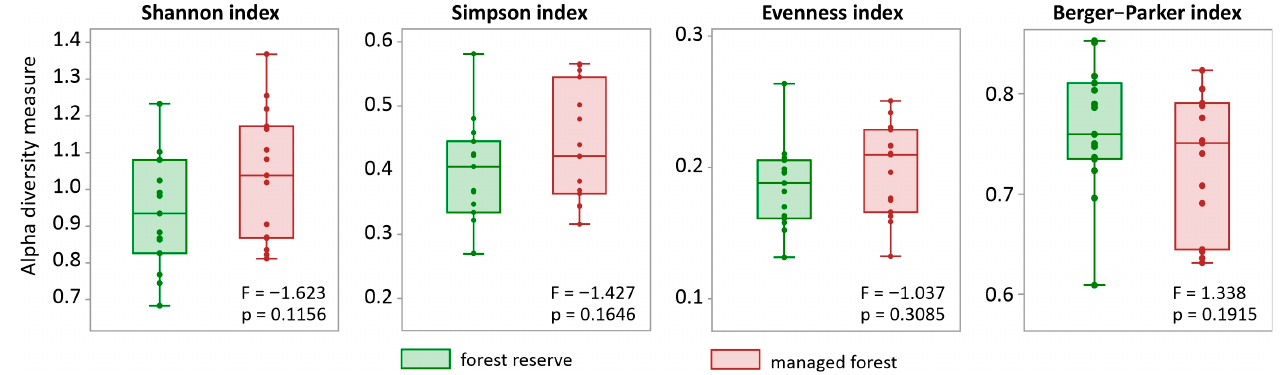
Figure 8. Comparison of captured Coleoptera community diversities between forest reserve and managed forest. Diversity was measured using the Shannon index, Simpson index, Evenness index, and Berger–Parker index. The top and bottom boundaries of each box indicate the 75th and 25th quartile values, respectively. The lines within each box represent the median values. The differences between alpha diversity indices were tested with a t